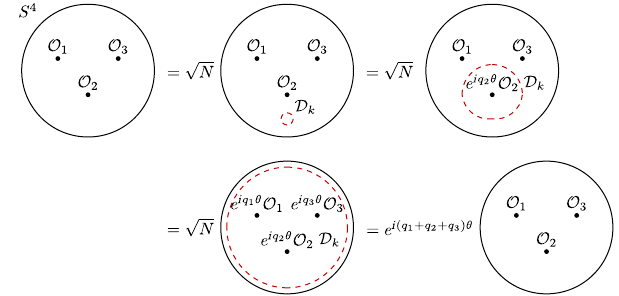
FIG. 1. The action of the noninvertible symmetry D correlation function on S 4 with local operator insertions with charge q 1 , q 2 , and q 3 . The rotation angle θ of the symmetry is 2 π =k . At the last step the defect is contracted at the other side of the